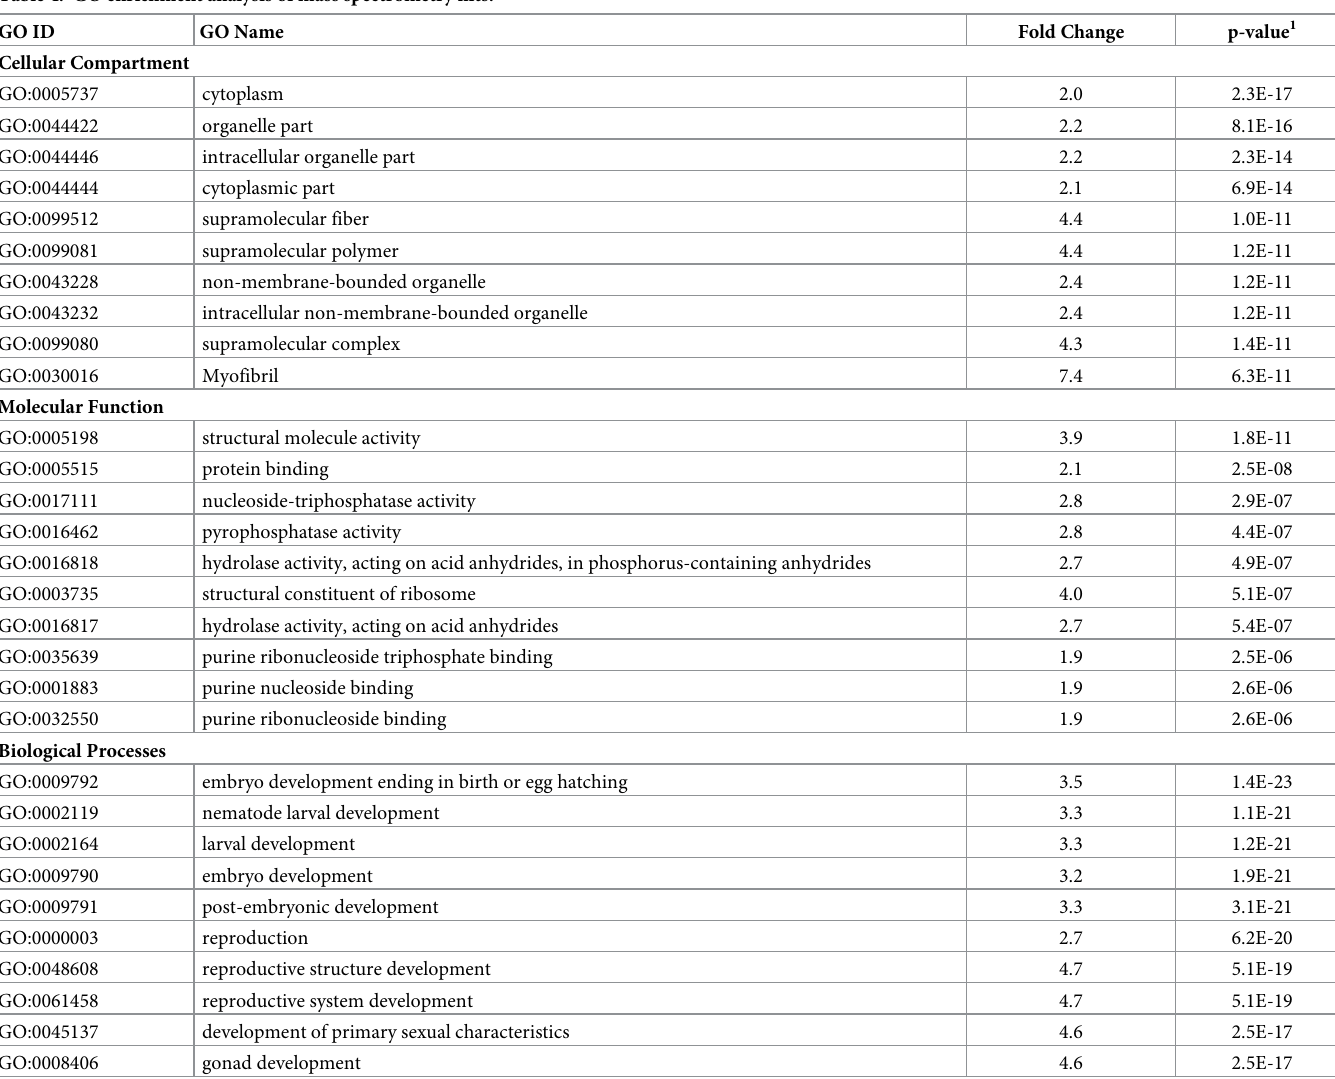
Table 4. GO enrichment analysis of mass spectrometry